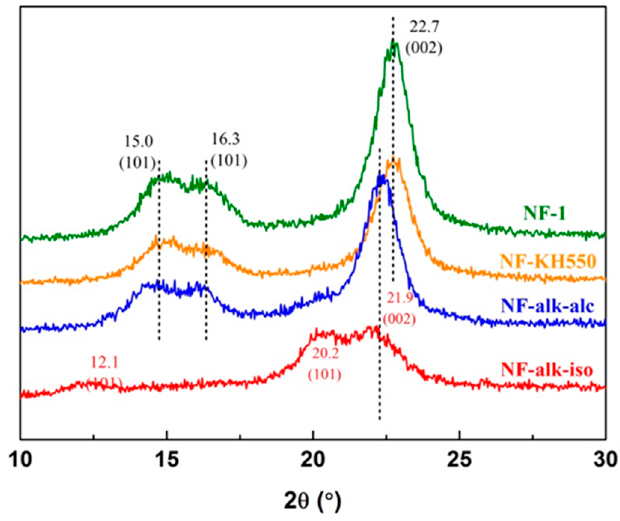
Figure 4. X-ray diffraction (XRD) curve of different modified ramie fabrics. Figure 4. X-ray di ff raction (XRD) curve of di ff erent modified ramie